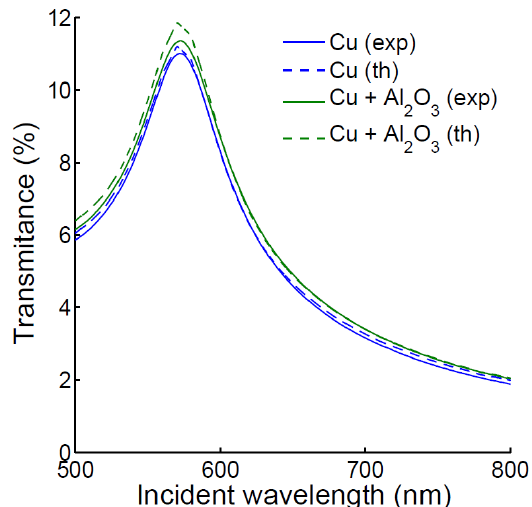
Figure 1. Experimental and simulated UV-visible spectra showing simulated and experimental transmittance of the optical chip coated with about 46 nm of Cu (blue) and with the addition of about 3 nm of Al 2 O 3 Cu (green). 3 nm of Al 2 O 3 Cu